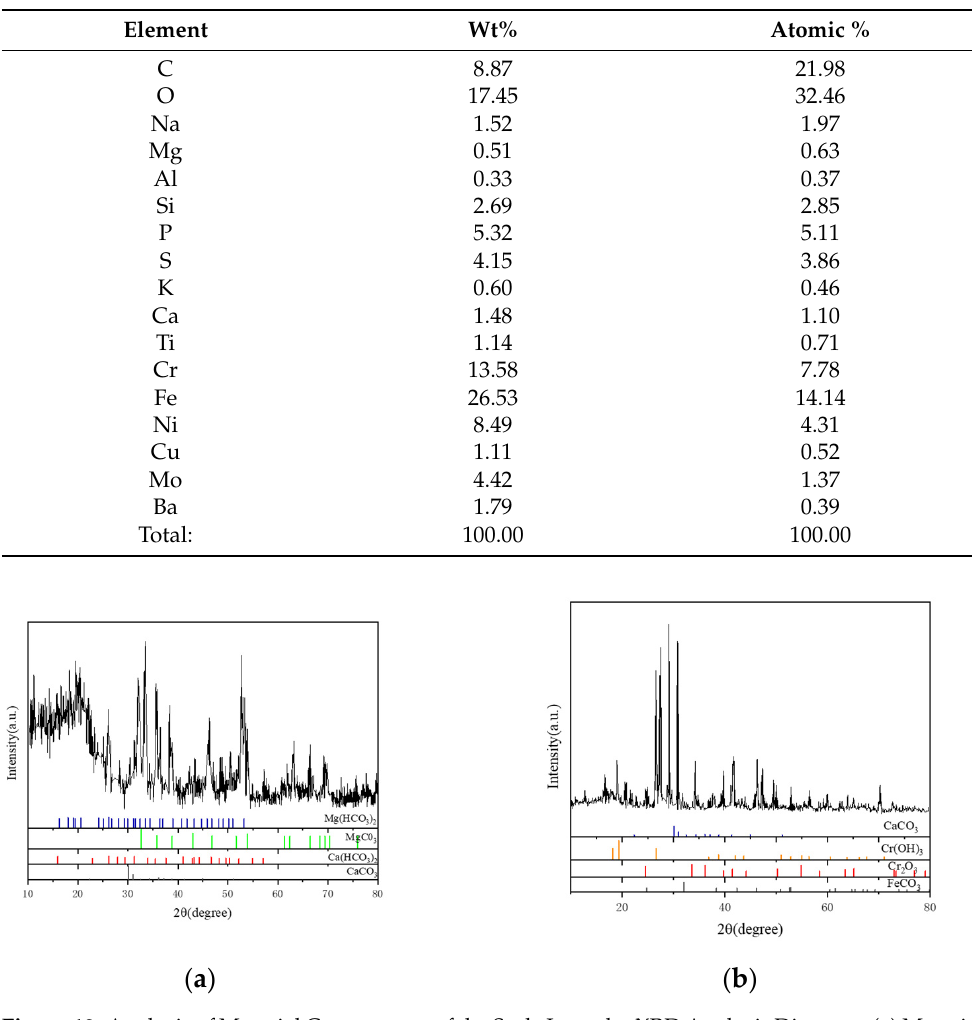
Figure 10. Analysis of Material Components of the Scale Layer by XRD Analysis Diagram. ( a ) Material Components of the Loose Layer. ( b ) Material Components of the Dense Layer.